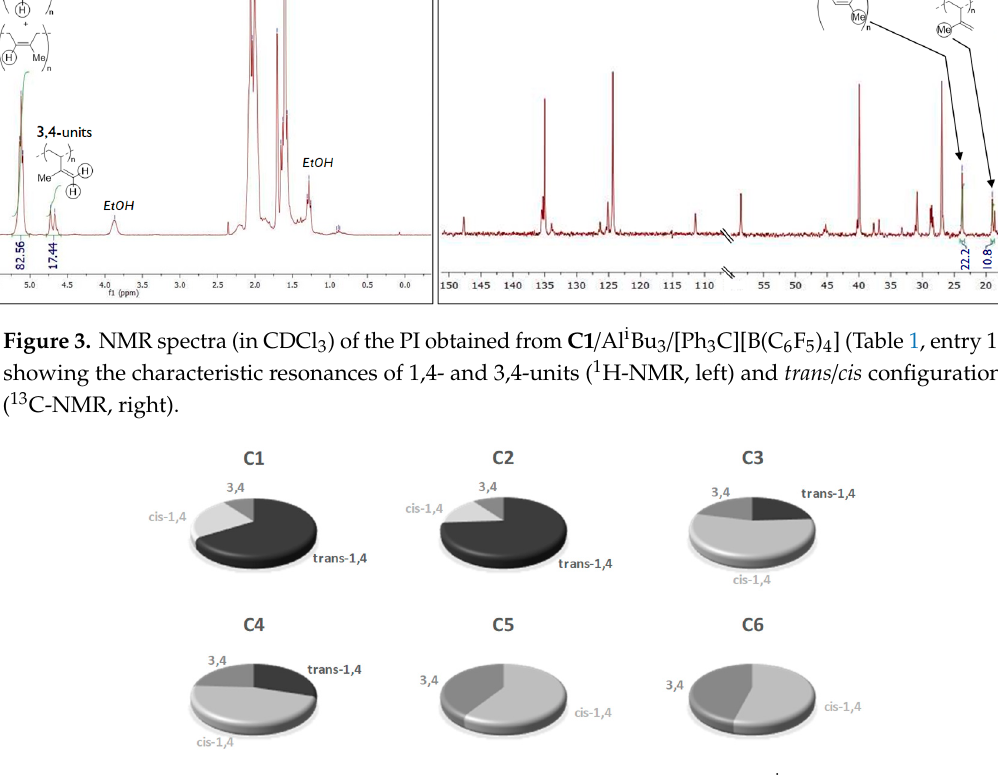
Figure 4. Microstructure content of the polyisoprene obtained from C1 – C6 / Al i Bu 3 / [Ph 3 C][B(C 6 F 5 ) 4 ].